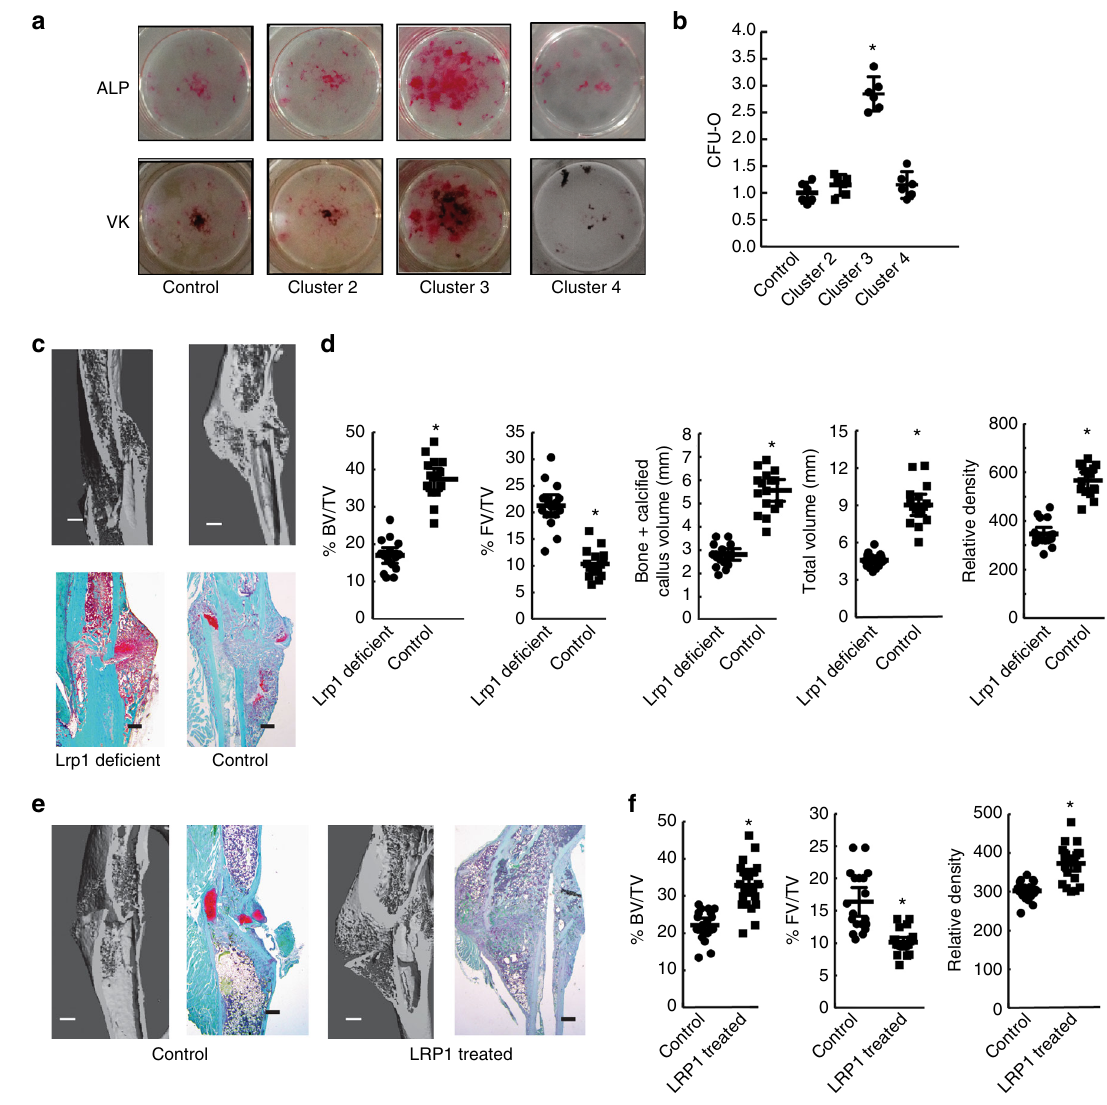
Fig. 4 Low-density lipoprotein receptor-related protein one in young macrophage cells plays a role in the rejuvenation of fracture repair. a and b CFU-O (Von Kossa (VK) or Alk Phosphate (ALP) staining) that form from bone marrow from old mice when treated with carrier (control) or various domains (clusters) of Lrp1. a Representative cell culture plates, and b each data point is shown as well as means and 95% con fi dence intervals for data for each experimental group, with the mean from control cultures de fi ned as “ 1 ” (right) are shown, n = 6, comparison using ANOVA. c and d Bone marrow from young mice lacking Lrp1 in macrophages or controls were transplanted into old mice, n = 9 males and 8 females for Lrp1-de fi cient mice and 8 males and 8 females for controls. c Representative micro-CT data and Safranin O stained histologic images 4 weeks after the fracture and d Graphs show bone volume/total volume (BV/TV) in %; total fi brous tissue/total volume (FV/TV) in %; bone plus calci fi ed callous volume (mm 3 ), total callous volume (mm 3 ), or relative density. Each data point is shown as well as means and 95% con fi dence intervals for data for each experimental group. An asterisk over a data point shows a signi fi cance p < 0.05 compared to controls, comparison using ANOVA. e and f Treatment with recombinant Lrp1 cluster three by daily injections at the fracture site for 2 days following generation of a tibia fracture improves fracture repair in old mice. e Representative micro-CT data and Safranin O stained histologic images 4 weeks after the fracture. f Bone volume/total volume (BV/TV) in %; total fi brous tissue/total volume (FV/TV), or relative density. n = 12 males and 11 females for Lrp1 treatment and 10 males and 9 females for controls. Each data point is shown as well as means and 95% con fi dence intervals for data for each experimental group. An asterisk over a data point shows a signi fi cance p < 0.05 compared to controls, comparison using